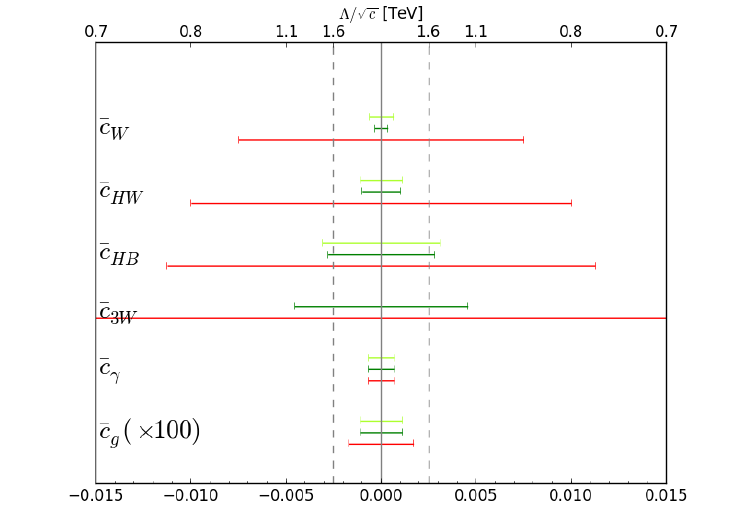
Figure 2 . The prospective sensitivities of CLIC measurements at 350 GeV to individual operator coe(cid:14)cients (green) and in a (cid:12)t marginalised over all contributing operators (red). The lighter green colour is for (cid:12)ts omitting the W + W (cid:0) production cross-section.